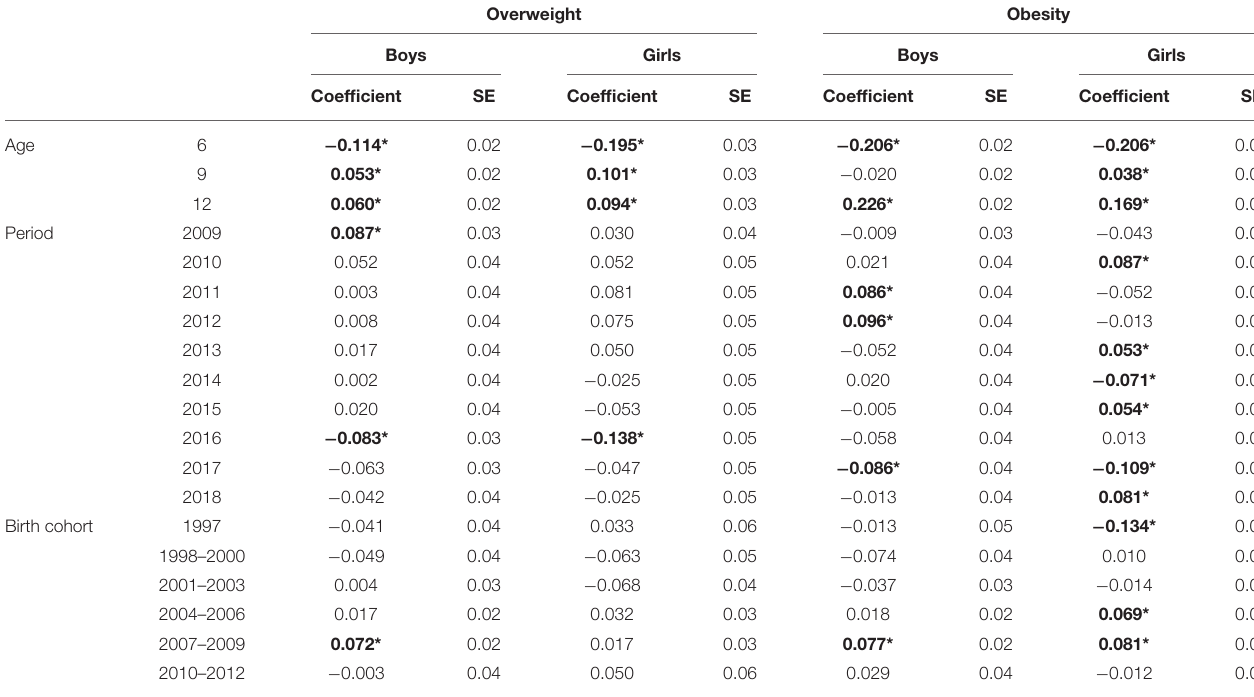
TABLE 4 | Age period cohort analysis of children overweight and obesity by sex group,